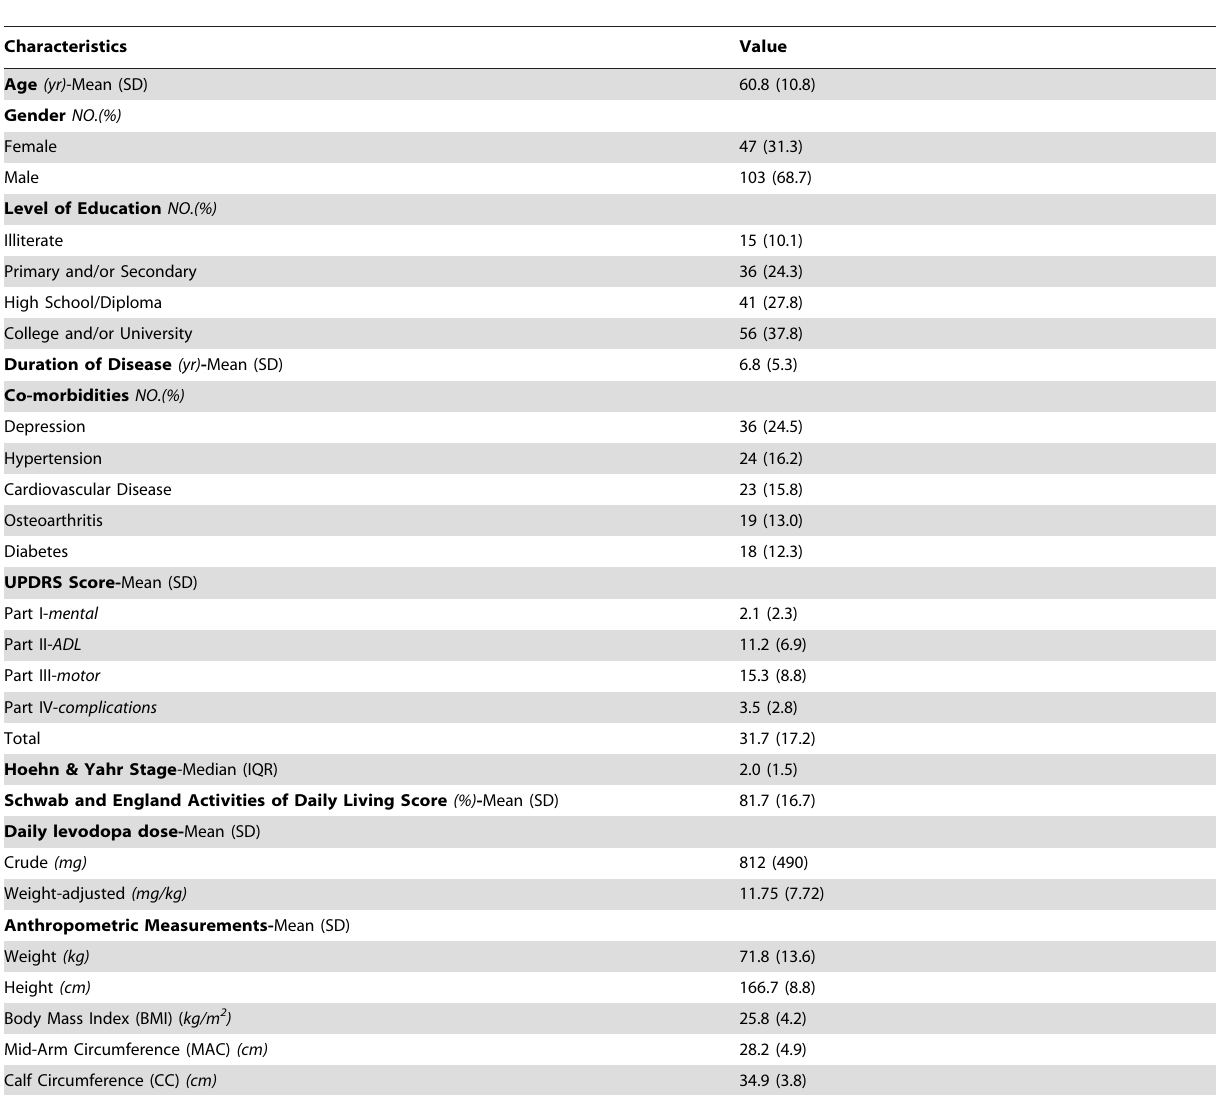
Table 1. Baseline, anthropometric and clinical characteristics of the recruited Parkinson’s disease patients (n=150).